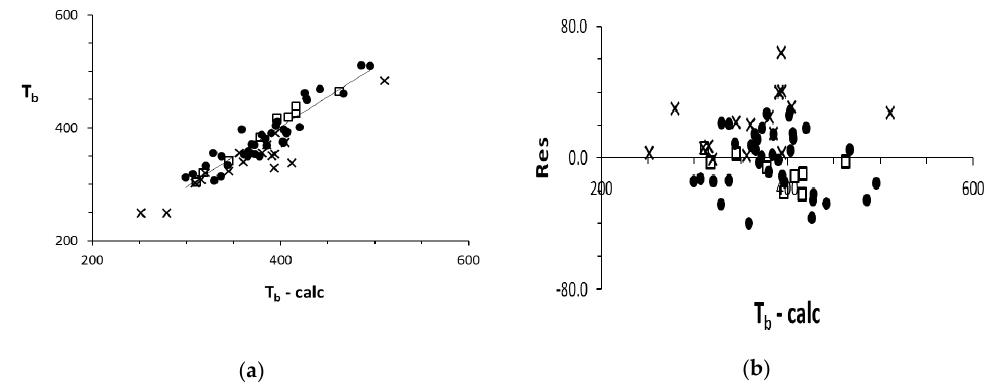
Figure 3. Plot of the Experimental vs. calculated (calc) boiling points, T b , ( a ) and the corresponding residual plot ( b ): (•) training points, ( □ ) test points, and ( × ) evaluated points. Statistics of evaluation (EV) points: N = 16, r 2 = 0.91, s = 17.